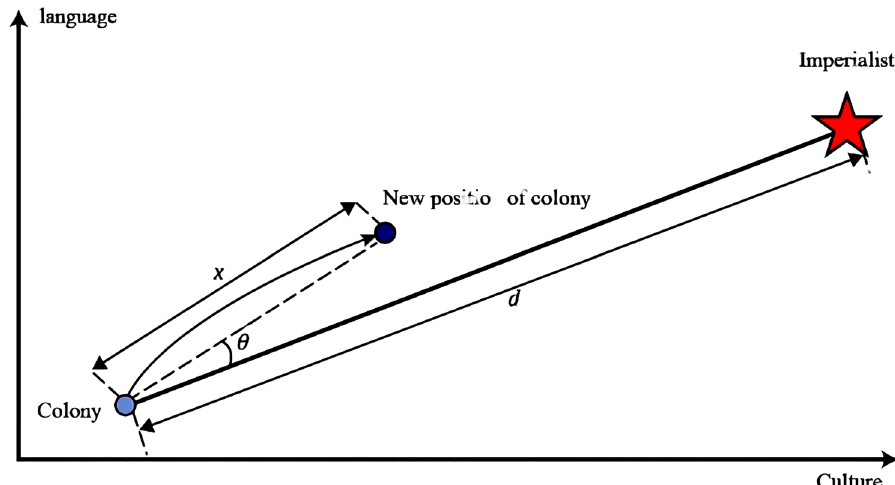
Fig. 4 Moving toward the imperialist competitive algo-